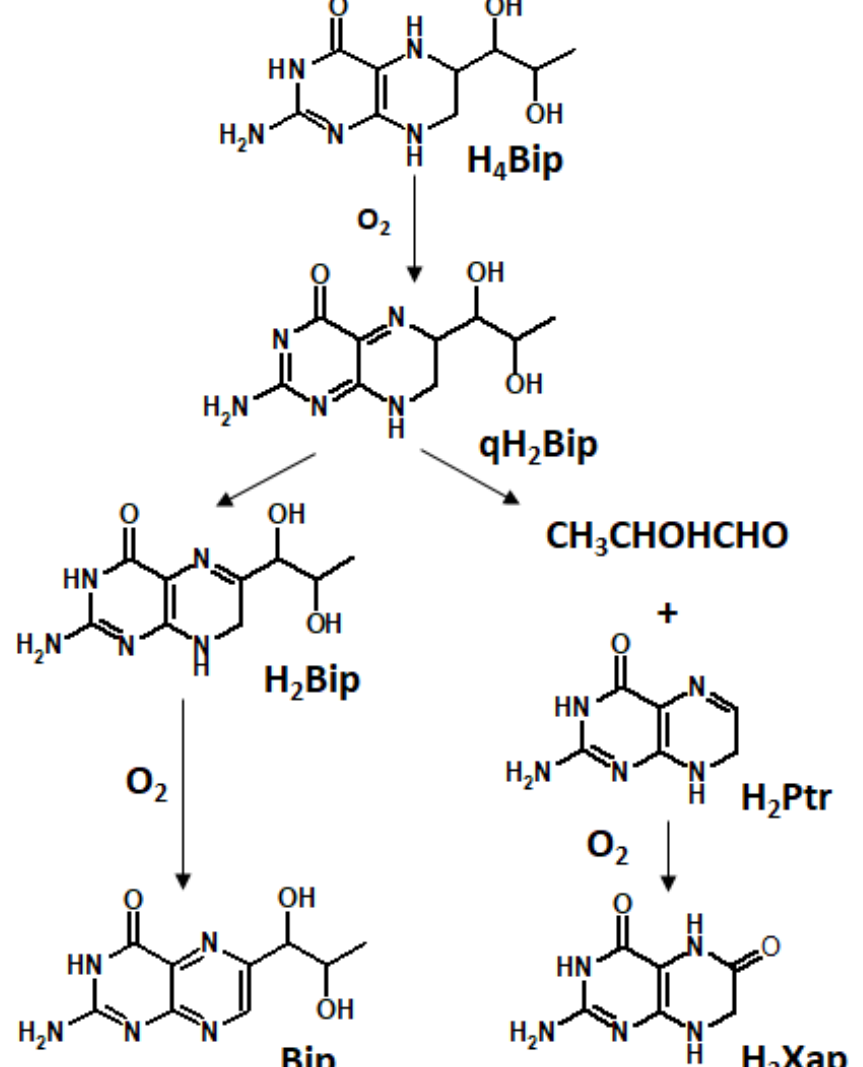
Figure 6. Scheme of H 4 Bip autoxidation in presence of molecular oxygen [26]. ©2014 Wiley. The rate constants of reactions 1, 2, and 3 are equal to 0.6 M − 1 s − 1 , 3.9 × 105 M − 1 s − 1 , and 3.2 × 103 M − 1 s − 1 , respectively. According to quantum chemical calculations, the oxidation